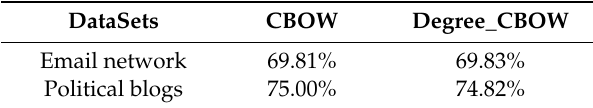
Table 2. Result of community